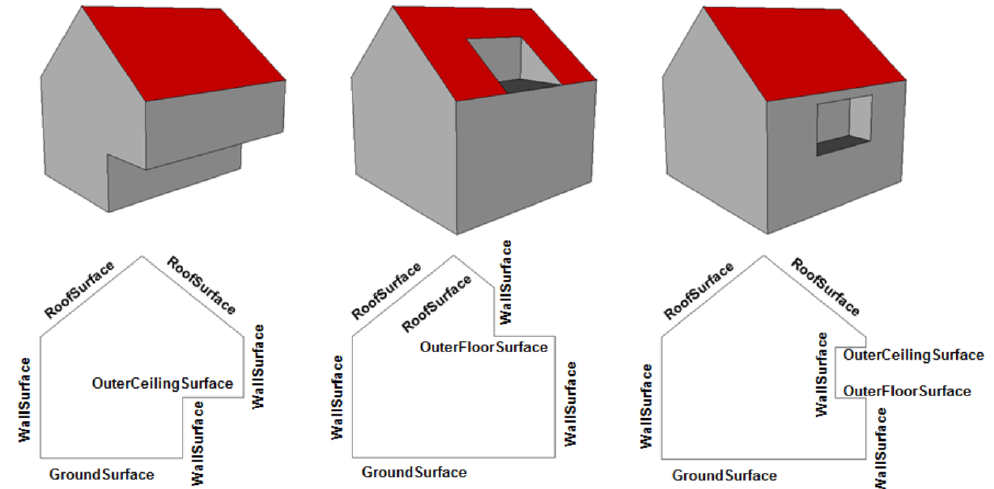
Figure 8. Examples of the classification of _BoundarySurfaces in CityGML of the outer building shell (Source: ref.